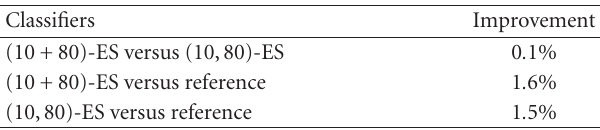
Table 4: Percentage of improvement per image of the maximum joint probability calculates between